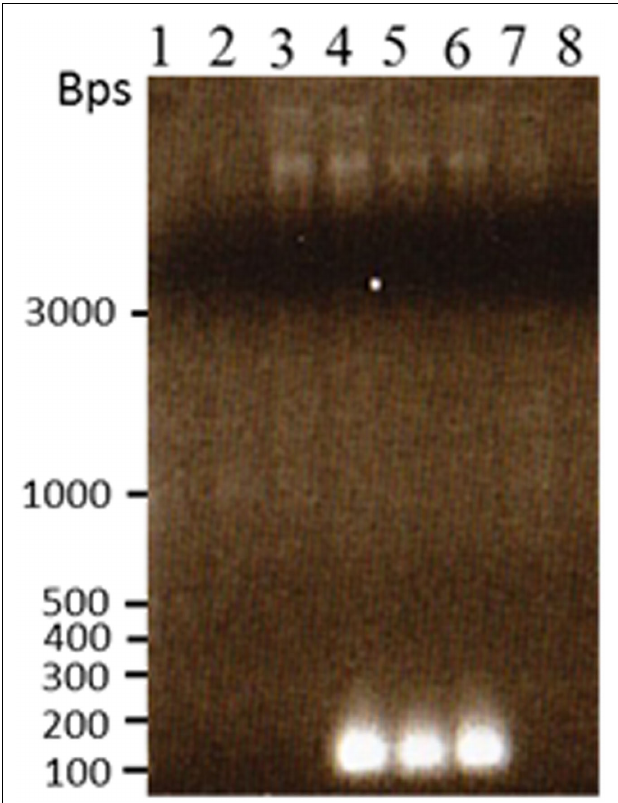
FIGURE 8 | Reamplification of the novel TCUP transposon site that was cloned and sequenced from the transposon display gel fragments. PCR was performed on undigested genomic DNA to confirm the novel sequence was present in H6 genomic DNA and not in other callus or plant genomics DNA. Lane 1 B73 seedling, lane 2 Hi-II A × B seedling, lane 3 Hi-II A × B callus line H3-6, lane 4 Hi-II A × B callus line H6-2, lane 5 Hi-II A × B callus line H6-3, lane 6 Hi-II A × B callus line H6-4, lane 7 Hi-II A × B callus line I9-9, lane 8 BMS